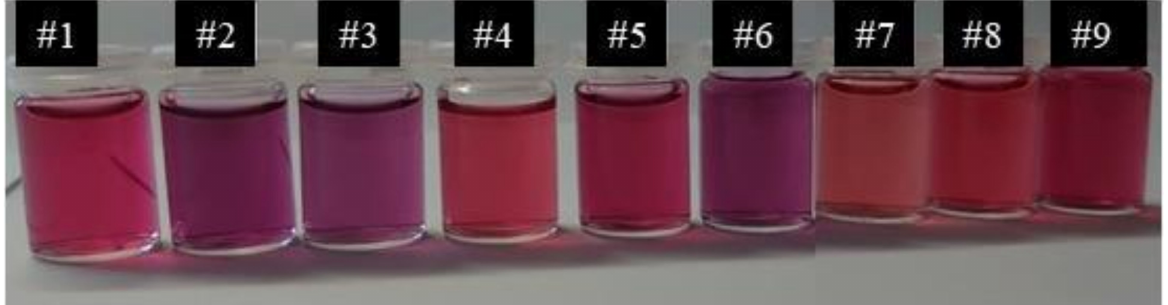
Figure 1. AuNP solutions synthesized by varying the acetic acid concentration and temperature according to the conditions reported in Table 1.